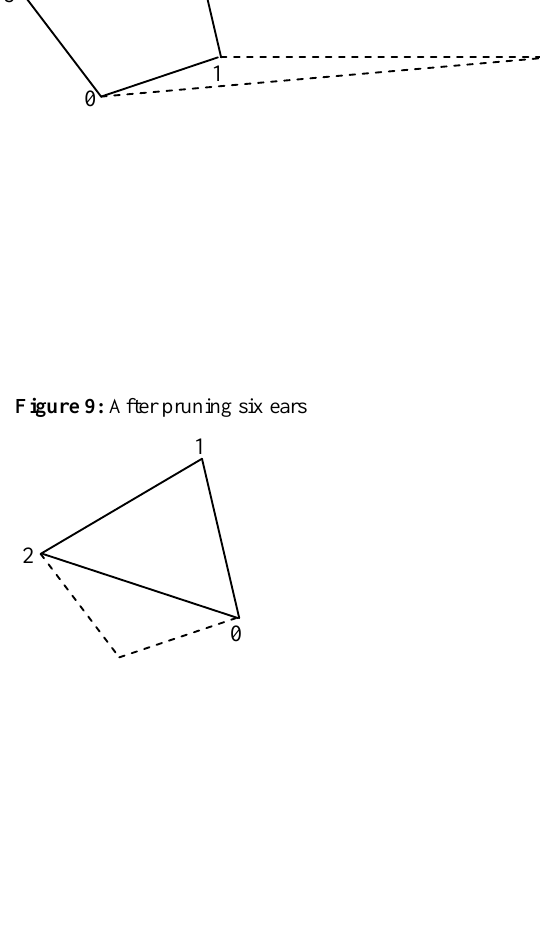
Figure 10: After pruning seven ears